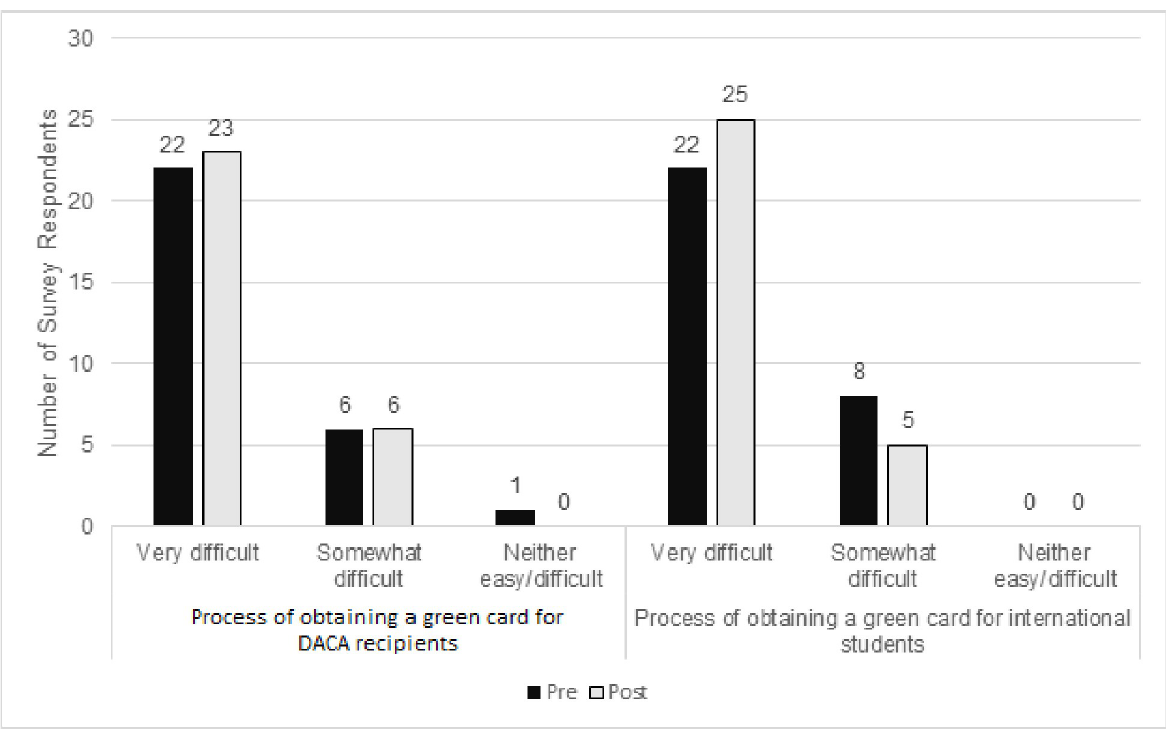
Fig 2. Pre-post survey results on difficulty obtaining permanent residency for DACA recipients and international students. Pre-program (black) and post-program (gray) survey response comparison of participant perceptions of difficulty obtaining permanent residency (i.e., green card) for students with DACA (left) and international visas